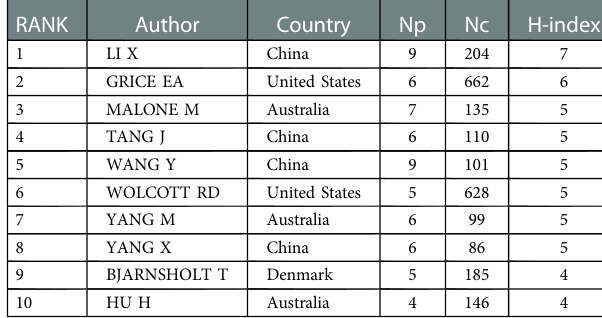
TABLE 3 The top 10 authors with the most publications about HTS associated with chronic